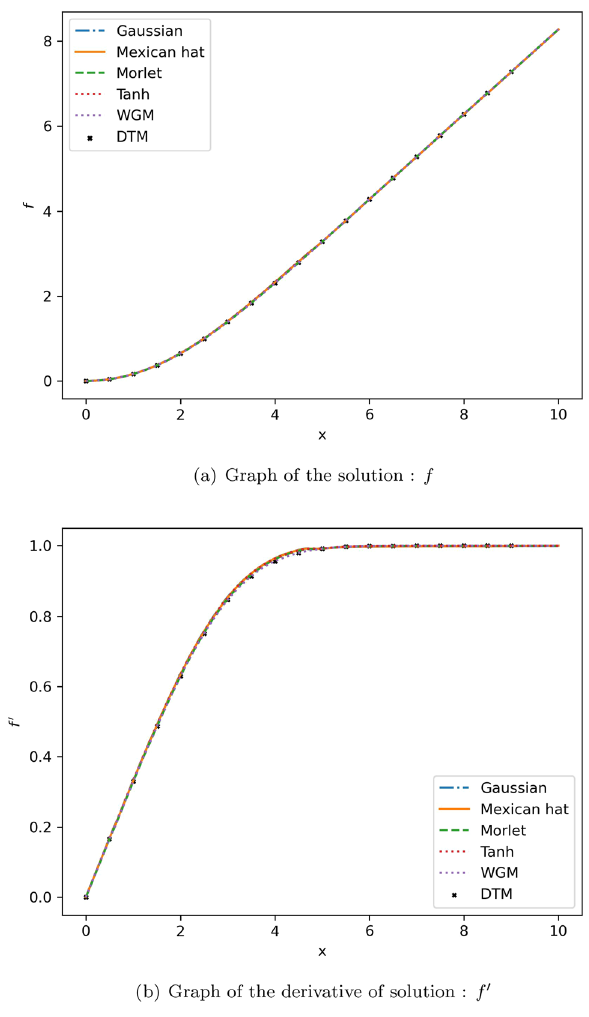
Figure 8. Comparison of the results of proposed method with different activation functions and existing results for the Blasius